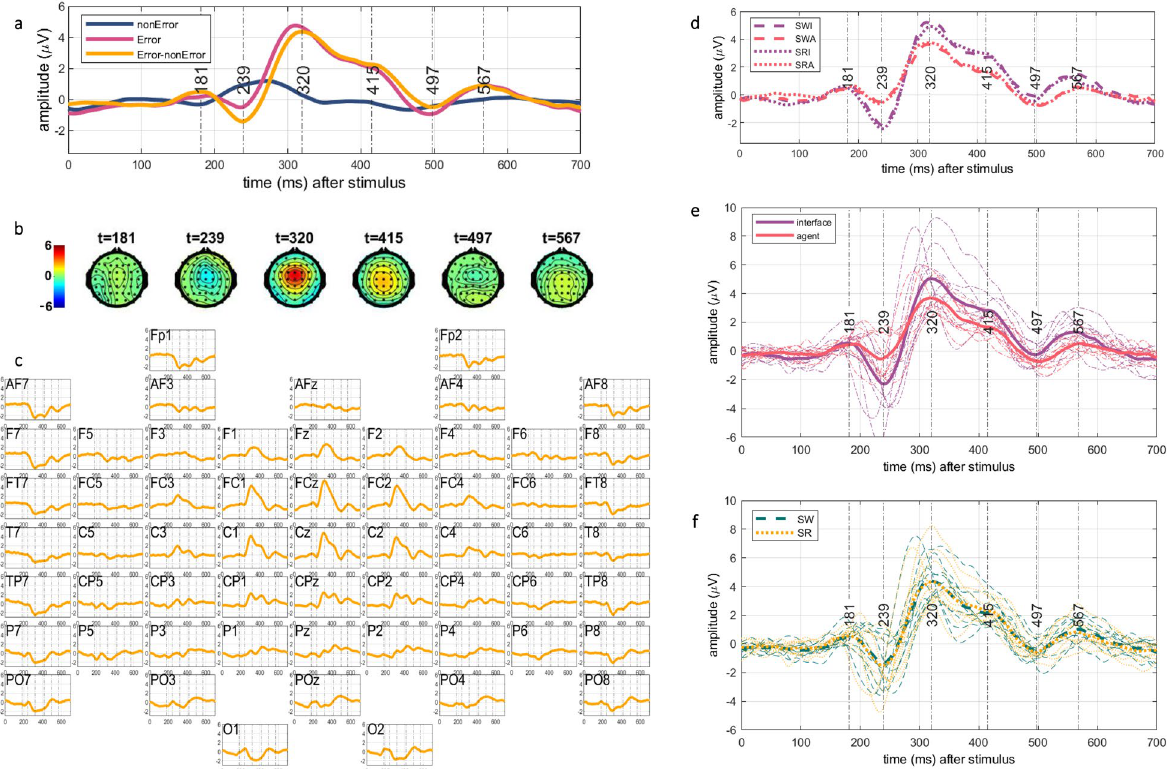
Figure 2. Grand average from all subjects and all trials: ( a ) the grand averaged signals on the Cz electrode for all error (pink) and non-error (dark blue) trials and their difference (orange) across all conditions in a time window between 0 and 700 ms after the object movement. Positive and negative peaks of the components can be observed around 181 ms, 239 ms, 320 ms, 415 ms, 497 ms, and 567 ms; ( b ) the topographic maps of the difference between the grand average of the error minus non-error trials for the positive and negative peaks in ( a ); ( c ) the difference of the grand averaged error and non-error signals across all electrodes; ( d ) differences in the amplitude of the responses for the different sources (interface in purple and agent in red) of the errors in the different scenarios. The dashed signals represent the grand averages of the Shared Workspace (SW) scenario, whereas the dotted signals represent the grand averages of the Shared Responsibility (SR) scenario; ( e ) the response for the interface errors (thick purple) at the peaks has higher amplitudes compared to the response for the agent errors (thick red). The thin dash-dotted lines show the averaged trials per subject; ( f ) the overlapping responses to the different scenarios (SW in green dashed lines, SR in orange dotted lines). The thick lines show the grand-averaged trials, and the thin lines the averages per subject.